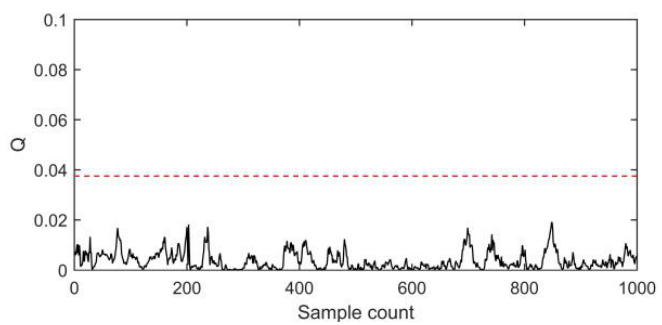
Figure 6. The Q -statistic of the EVT based on traditional PCA.